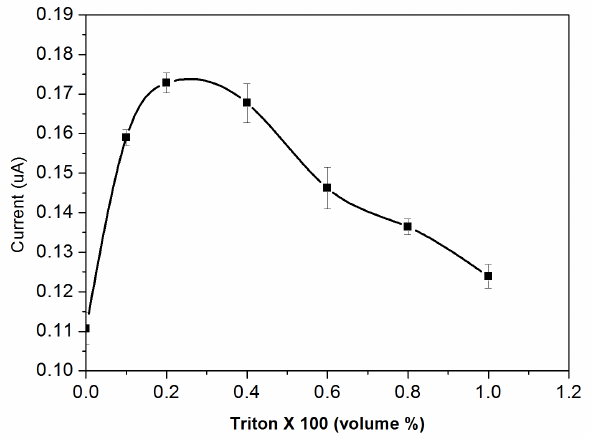
Figure 5. Effect of the surfactant Triton X-100 quantity contained of the